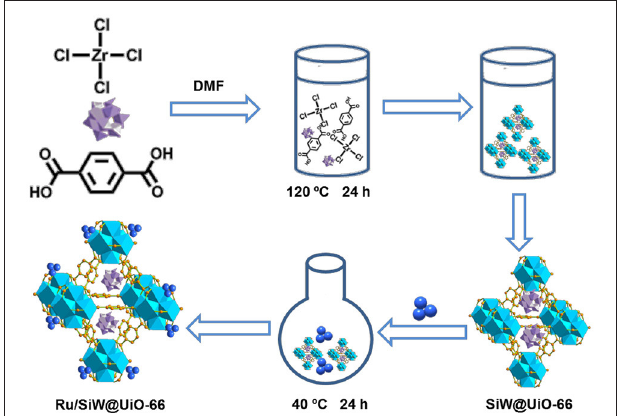
SCHEME 2 | Schematic showing the preparation procedure of the Ru/SiW@UiO − 66 catalyst. Purple polyhedra: SiW, dark blue ball: Ru NPs, sky blue framework: UiO −